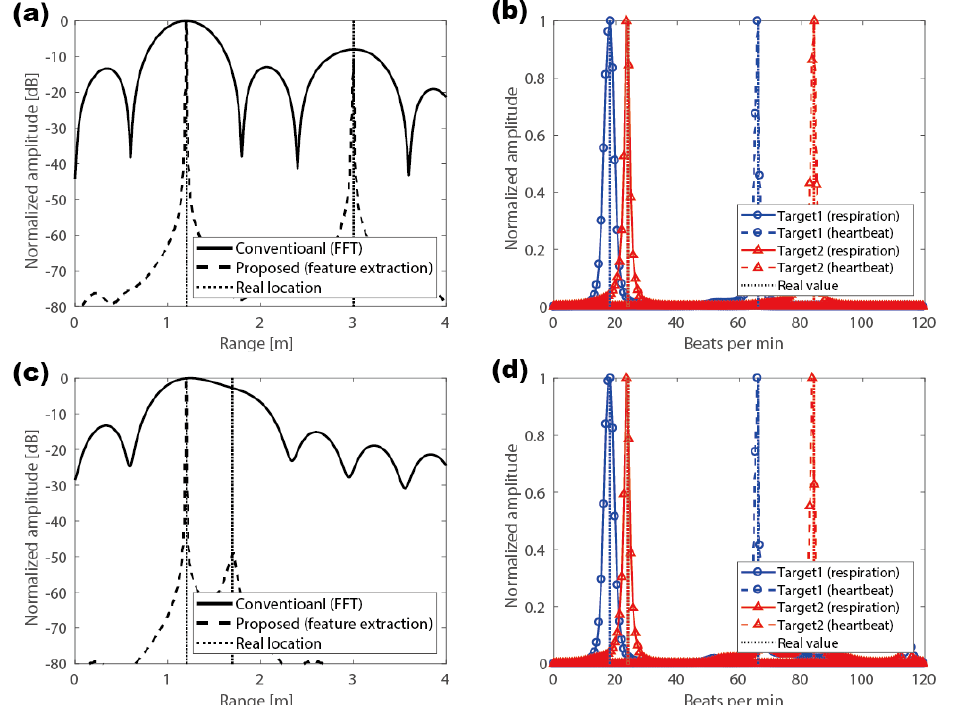
Figure 5. Simulation results for two targets: ( a ) range estimation for two targets at distances of 120 and 300 cm; ( b ) heart rate and respiration extraction for two targets at distances of 120 and 300 cm using the AR method; ( c ) range estimation for two targets at distances of 120 and 170 cm; and ( d ) heart rate and respiration extraction for two targets at distances of 120 and 170 cm using the AR